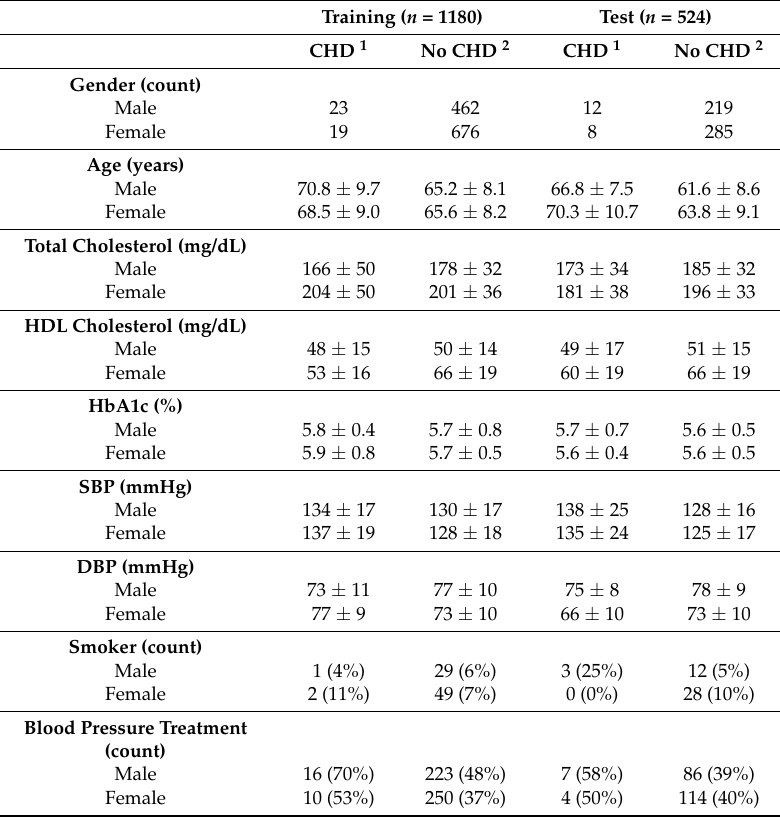
Table 1. Summary of demographics and conventional coronary heart disease (CHD) risk factors at the eighth examination cycle for the 1180 and 524 individuals in the training and test sets,